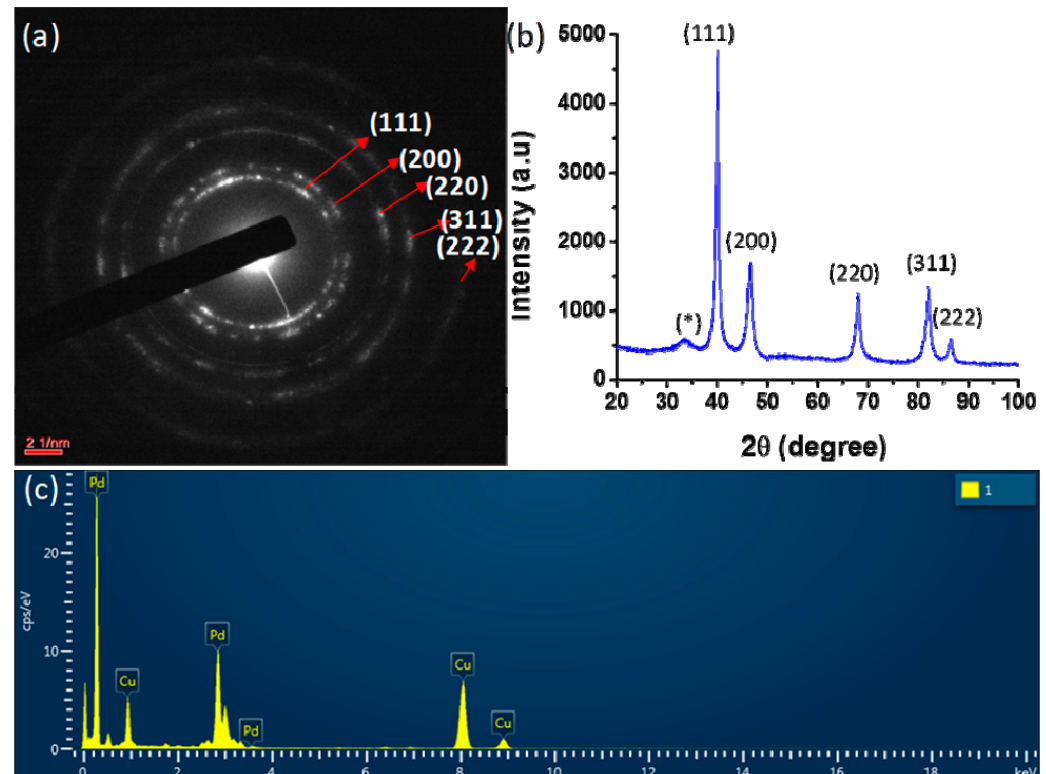
Figure 3. Biosynthesized PdNCs: ( a ) Selected area electron diffraction (SAED) pattern showing the presence of rings corresponding to the crystalline nature of nanoclusters; ( b ) X-ray diffraction (XRD) pattern (*the reflections due to residual moieties of the leaf extract); and ( c ) Energy-dispersive X-ray spectroscopy (EDX) spectrum exhibiting the signal for elemental palladium.